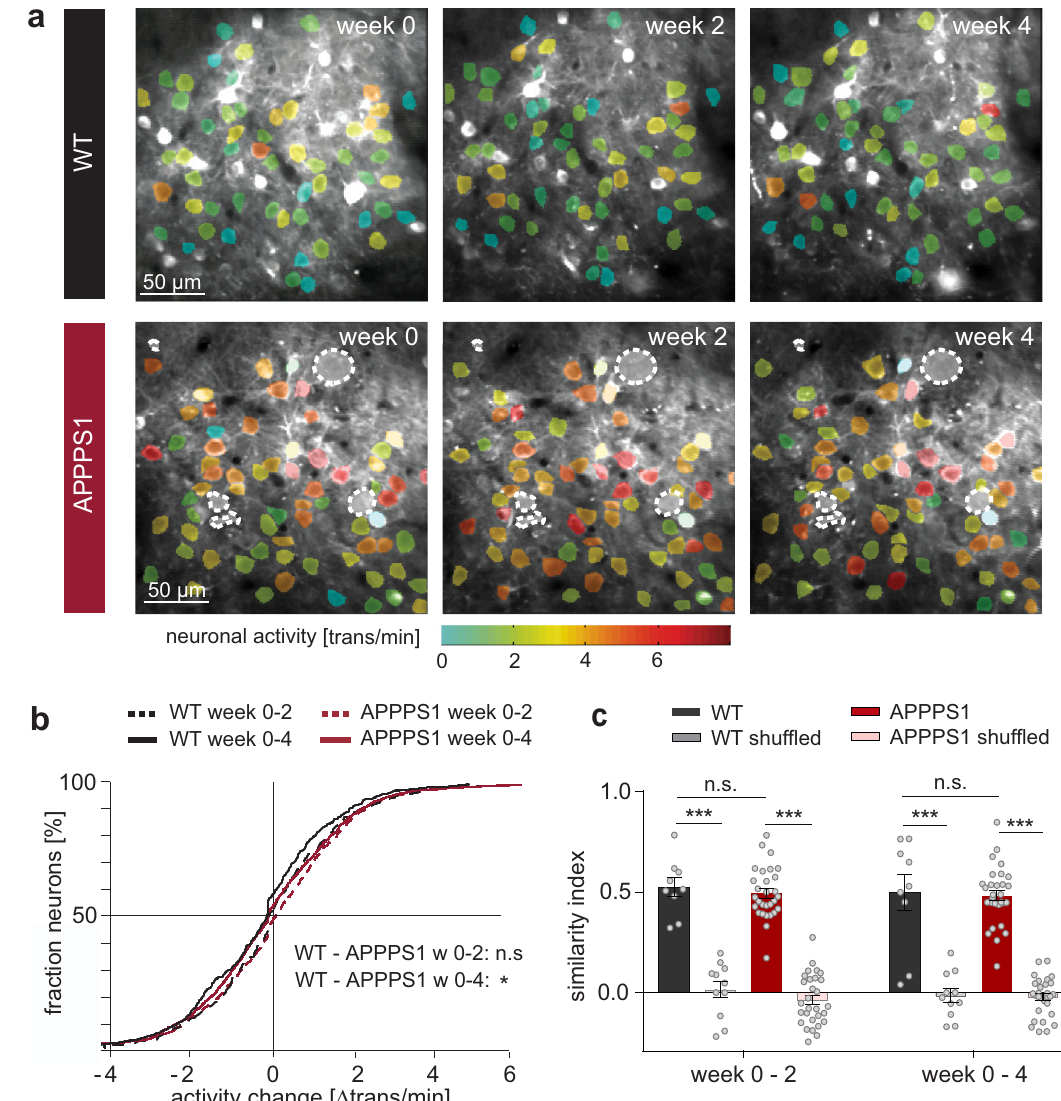
Fig. 3 Neuronal activity levels are largely stable over time. a Representative FOVs across all 3 time points from a WT and APPPS1 mouse, superimposed by the ROI (region of interest) selection mask (color codes for neuronal activity (transients per minute); fi lled cells were not included in the analysis; dashed lines: amyloid plaques). b Change in neuronal activity (week 0 – 2: p = 0.08, week 0 – 4: p = 0.03, KS test, WT n = 471 neurons (5 mice), APPPS1 n = 1514 neurons (9 mice)). c Similarity of neuronal activity within a given fi eld of view (week 0 – 2: F = 105.7, p < 10 − 4 , one way ANOVA, WT vs WT 3,74 shuf fl ed p < 10 − 4 , WT vs APPPS1 p = 0.9, APPPS1 vs APPPS1 shuf fl ed p < 10 − 4 , Bonferroni ’ s p ost-hoc test; week 0 – 4: F 3,74 = 78.51, p < 10 − 4 , one way ANOVA, WT vs WT shuf fl ed p < 10 − 4 , WT vs APPPS1 p = 0.9, APPPS1 vs APPPS1 shuf fl ed p < 10 − 4 , Bonferroni ’ s post-hoc test). Data are mean ± SEM. * p < 0.05, *** p <